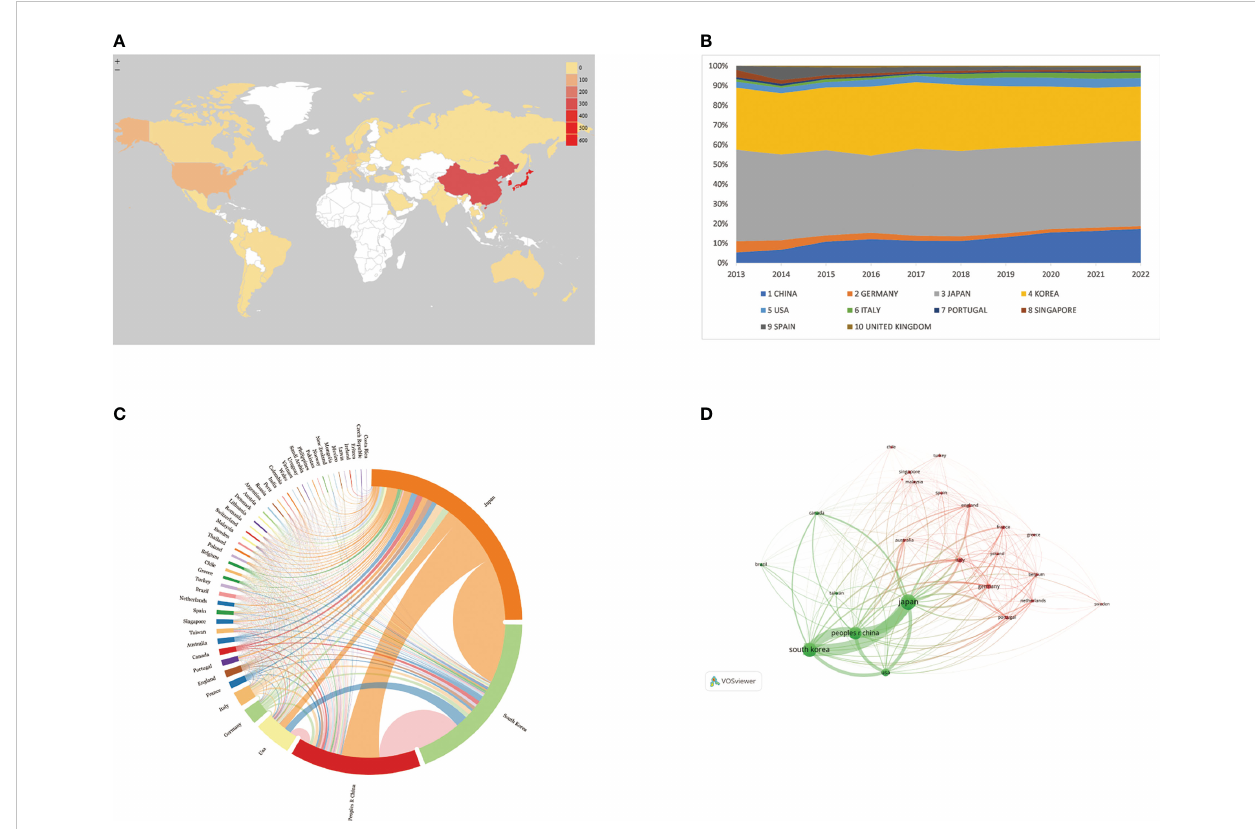
FIGURE 3 (A) World map based on the total publications of different countries/regions, performed by Microsoft Excel. (B) The changing consistency of the annual publication quantity in the top 10 countries/regions from 2013 to 2022, performed by Microsoft Excel. (C) Charticulator's map of worldwide countries/regions. The thickness of links between countries regions symbolizes collaboration, whereas ring surface area denotes publications. (D) VOSviewer's map showing countries/regions with more than 4 publications. Size of nodes and thickness of linkages indicate publishing quantity and connection strength.